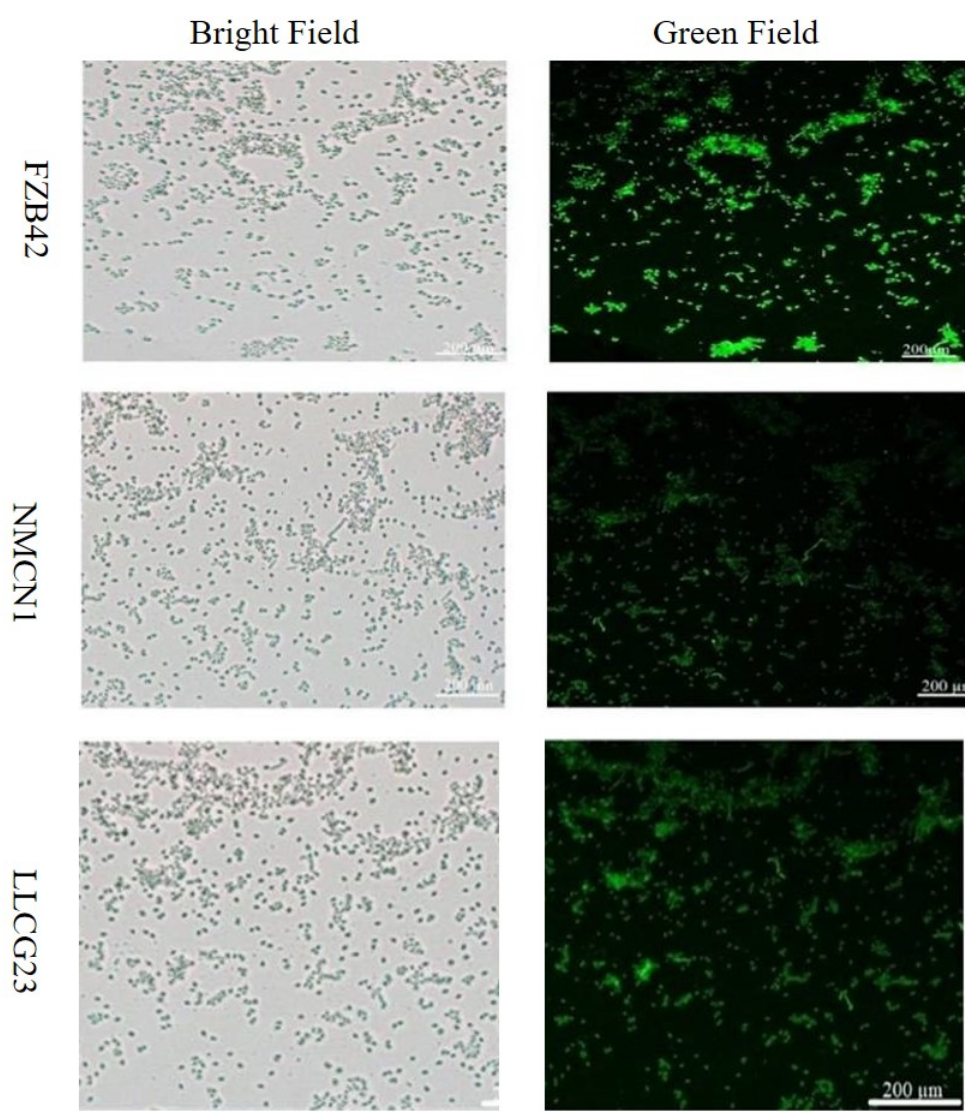
Figure 3. The intensity of green fluorescence indicates the level of Reactive Oxygen Species (ROS) in selected Bacillus strains grown at 37 °C in saline condition for 4 days. The less intense fluorescence observed in NMCN1 and LLCG23 strains describes lower ROS production in their cells under salt stress while the high intensive green fluorescence in FZB42 strain displays more ROS production under saline condition. The experiment was repeated thrice similar results.